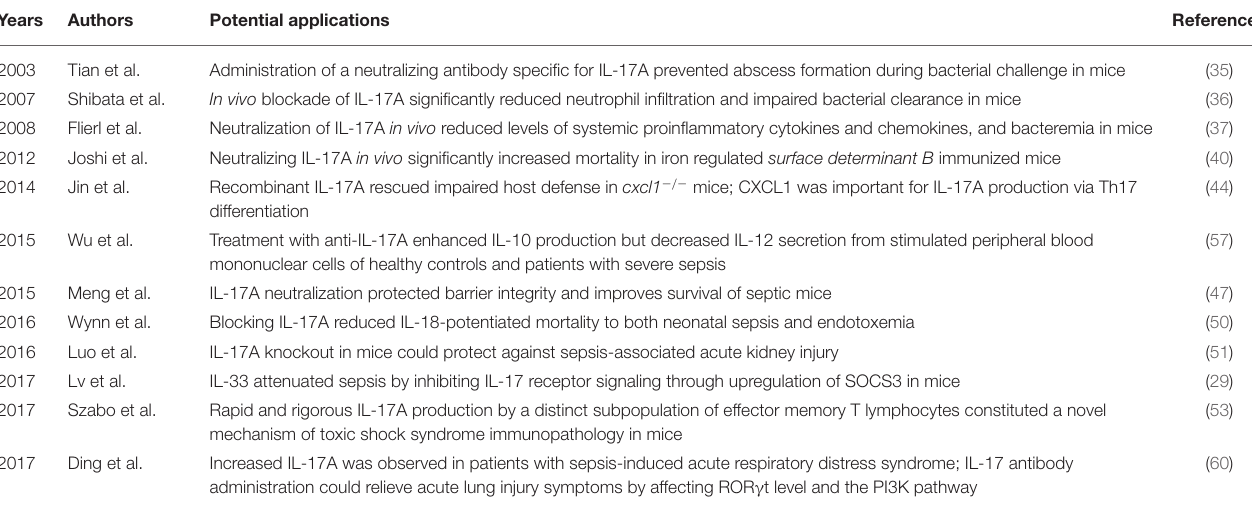
TABLE 2 | Summary of studies on potential applications of IL-17 targeting in